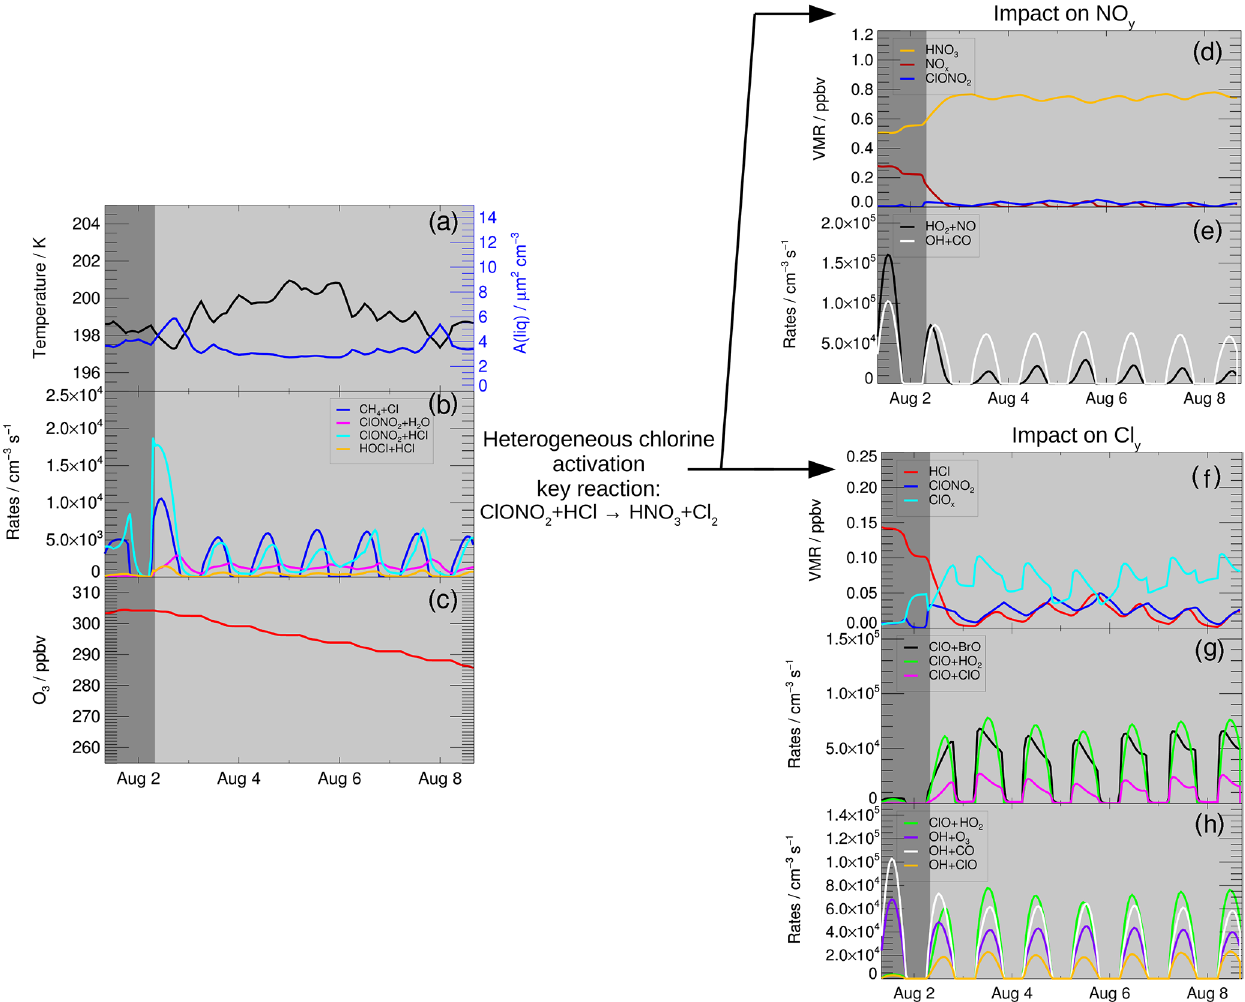
Figure 4. Reaction rates and mixing ratios important for the ozone loss mechanism in the standard simulation using 15ppmv H 2 O. The chlorine activation phase is shaded in dark grey, while the phase of ozone loss has a light grey background. Panel (a) shows the temperature of the trajectory and the liquid surface area density; the ozone mixing ratio is presented in panel (c) . Heterogeneous reaction rates are shown in panel (b) as well as the rate of the gas phase reaction CH 4 + Cl. Panel (d) shows the mixing ratio of HNO 3 (gas phase + condensed), NO x and ClONO 2 , and (e) shows the role of NO y for the ozone loss process. Reaction (R4) (OH + CO, panel e ) limits ozone formation in cycle (C1) at high NO x mixing ratios and Reaction (R6) (HO 2 + NO) at lower NO x concentrations. Panels (f) – (h) illustrate the role of chlorine for ozone loss by showing the mixing ratio of HCl, ClO x and ClONO 2 ( f ), main reaction rates (Reaction R16, ClO + ClO, Reaction R17, ClO + BrO, Reaction R13, ClO + HO 2 ) for catalytic ozone loss cycles ( g ) and potential reaction pathways for the OH radical (Reaction R4, OH + CO, Reaction R18, OH + ClO, Reaction R15, OH + O 3 ) as possible reaction chains following Reaction (R13) (ClO + HO 2 ) ( h ). The x axis marks refer to 00:00 local time